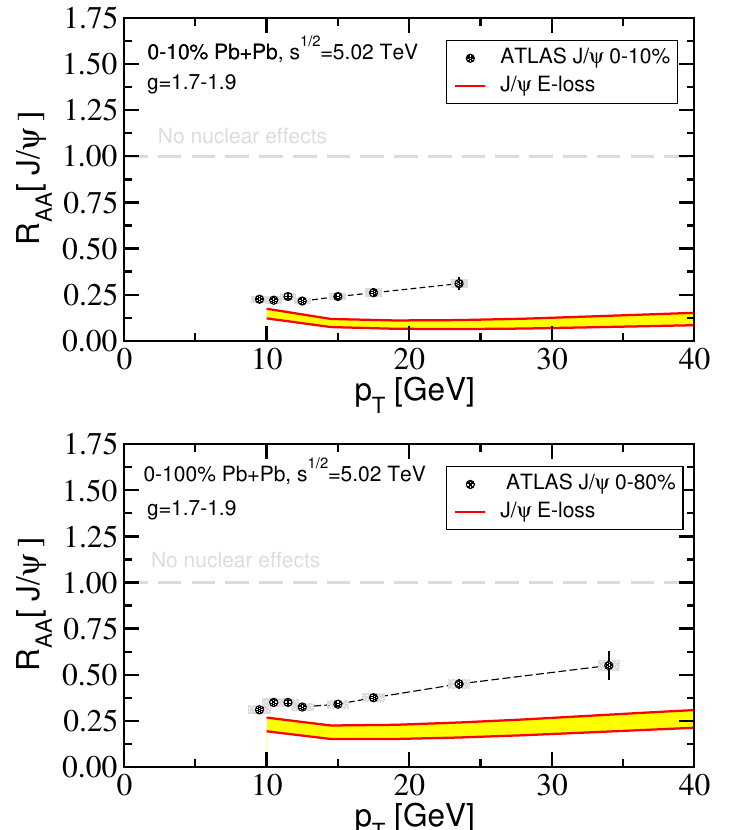
Figure 3 . Comparison of the suppression of J= (yellow band) evaluated in an energy loss model with coupling between the fragmenting parent parton and the medium g = 1 : 7{1 : 9 to ATLAS data from p s NN = 5 : 02 TeV Pb+Pb collisions at the LHC [44]. Upper panel: comparison between theory and data in the most central 0{10% collisions. Lower panel: comparison between theory and data in minimum bias collisions, the exact centrality class of ATLAS data is